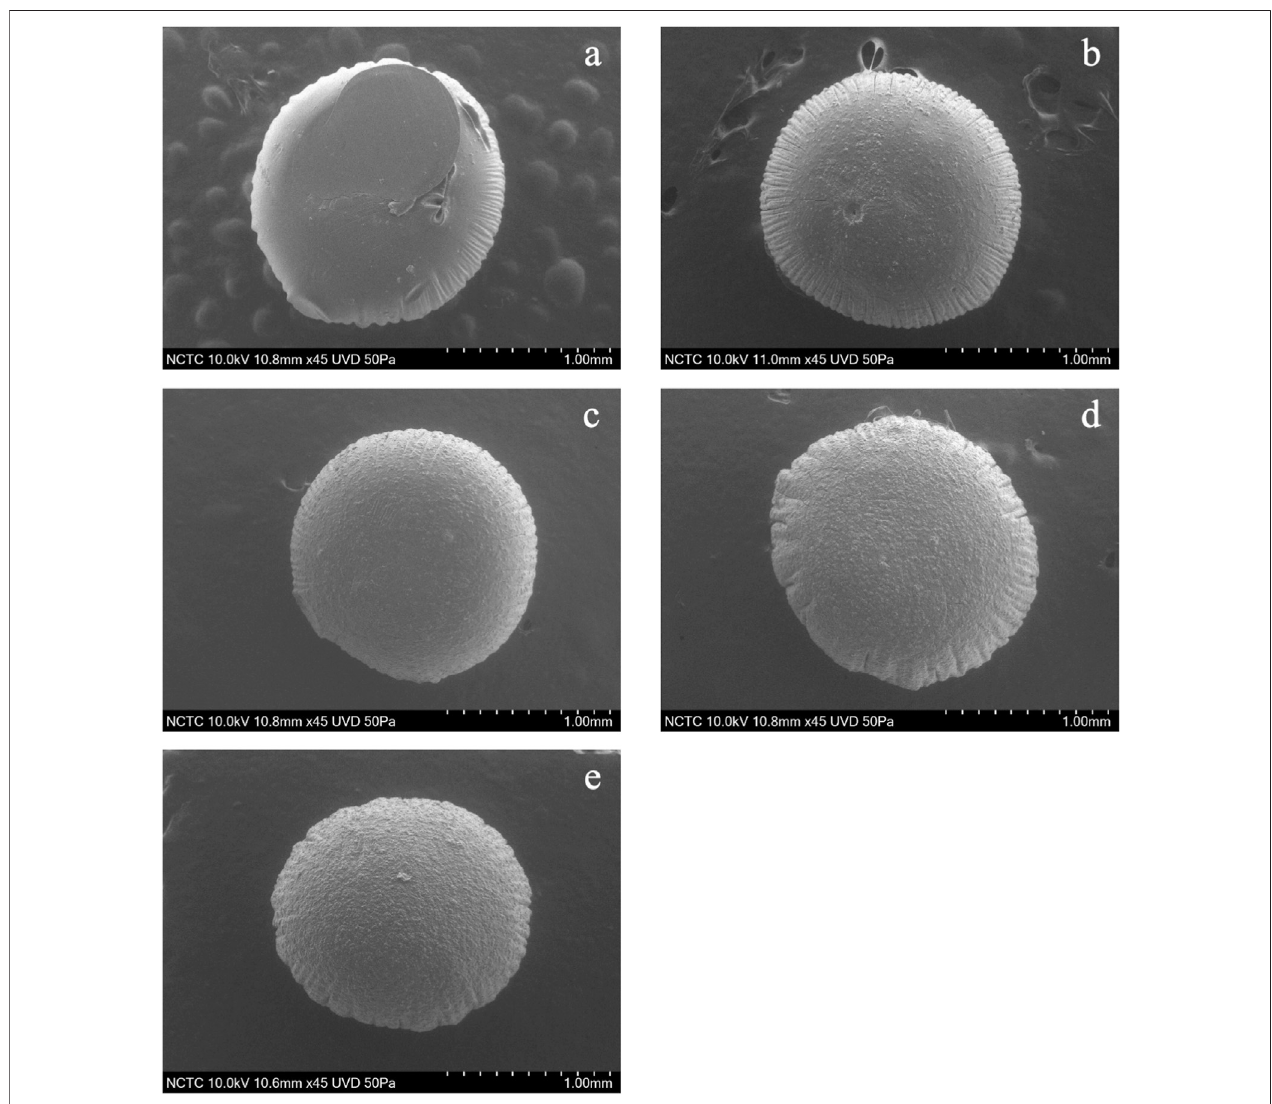
FIGURE 3 | Scanning electron microscopy (SEM) images (magni fi cation × 50) showing the surface morphology of pectin/hi-maize starch hydrogel beads with different pectin:hi-maize starch ratios: (A) bead P1 (6: 0), (B) bead P2 (5.5: 0.5), (C) bead P3 (5: 1), (D) bead P4 (4.5: 1.5), and (E) bead P5 (4: 2).